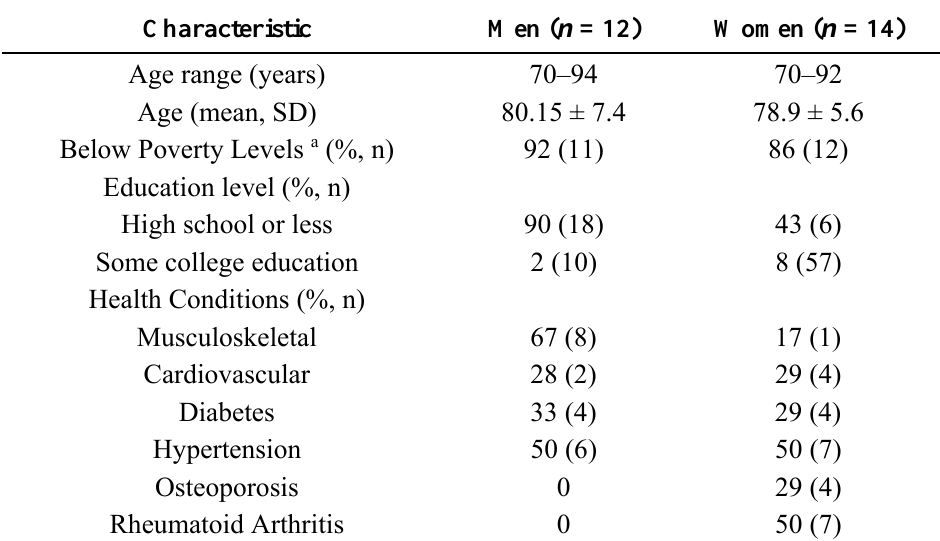
Table 1. Participants’